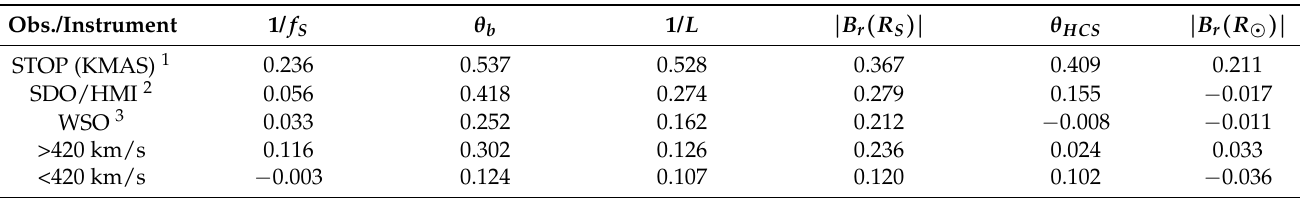
Table 1. Pearson correlation coefficients between magnetic field parameters and SW velocity accord- ing to CR averaged values.